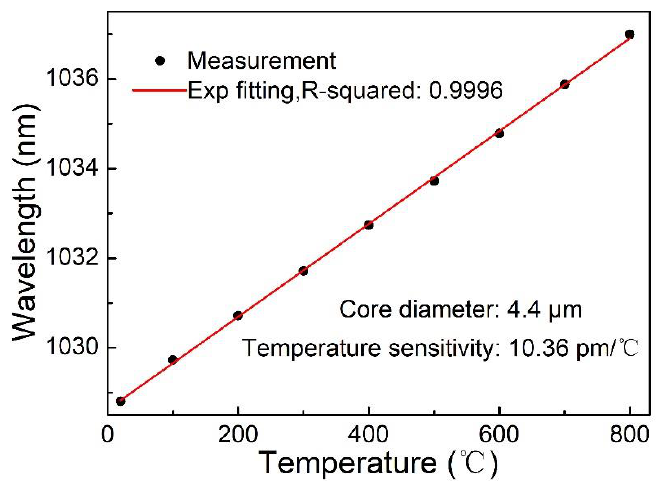
Figure 6. The relationship between the resonant wavelength of an apodized FBG with a core diameter of 4.4 μm and temperature.